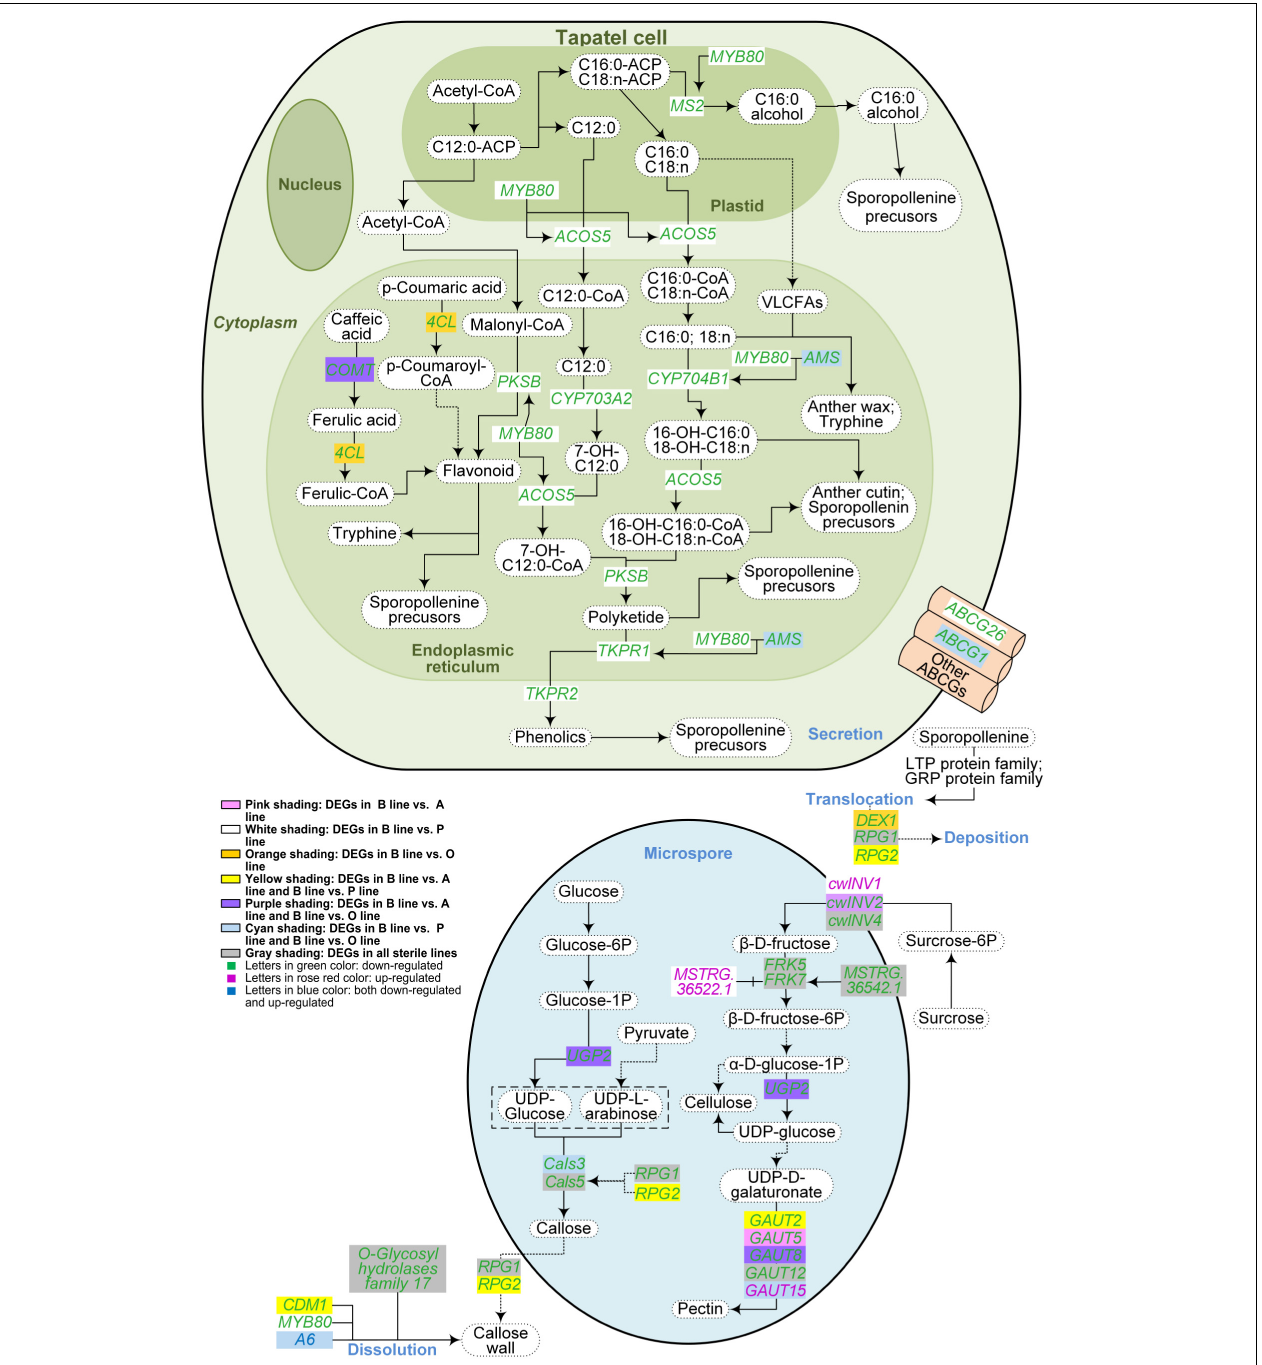
FIGURE 4 | Metabolism pathways of pollen wall components in the three sterile lines of Brassica campestris . Differentially expressed genes associated with the metabolism of sporopollenin, cellulose, pectin, and callose were indicated in the figure. The solid arrows represent a direct relationship, and the dotted arrows indicate an indirect relationship. B line, the fertile line ‘ Bcajh97-01B ’; A line, the genic male-sterile line ‘ Bcajh97-01A ’; P line, the Polima cytoplasmic male-sterile line ‘ Bcpol97-05A ’; O line, the Ogura cytoplasmic male-sterile line ‘ Bcogu97-06A ’; MYB80, MYB domain protein 80; MS2, male sterility 2; ACOS5, acyl-CoA synthetase 5; COMT, caffeate O -methyltransferase; 4CL, 4-coumarate:CoA ligase; PKSB, polyketide synthase B; CYP703A2, cytochrome p450 family 703 subfamilies A polypeptide 2; CYP704B1, cytochrome p450 family 704 subfamily B polypeptide 1; AMS, aborted microspores; VLCFAs, very-long-chain fatty acids; TKPR1/2, tetraketide α -pyrone reductase 1/2; ABCG, Adenosine triphosphate (ATP)-binding cassette, subfamily G; UGP, uridine diphosphate (UDP)-glucose pyrophosphorylase; Cals, callose synthase; DEX1, defective in exine formation 1; RPG1/2, ruptured pollen grain 1/2; CDM1, callose defective microspore 1; cwINV, cell wall invertase; FRK, fructokinase; GAUT, galacturonosyl transferase.